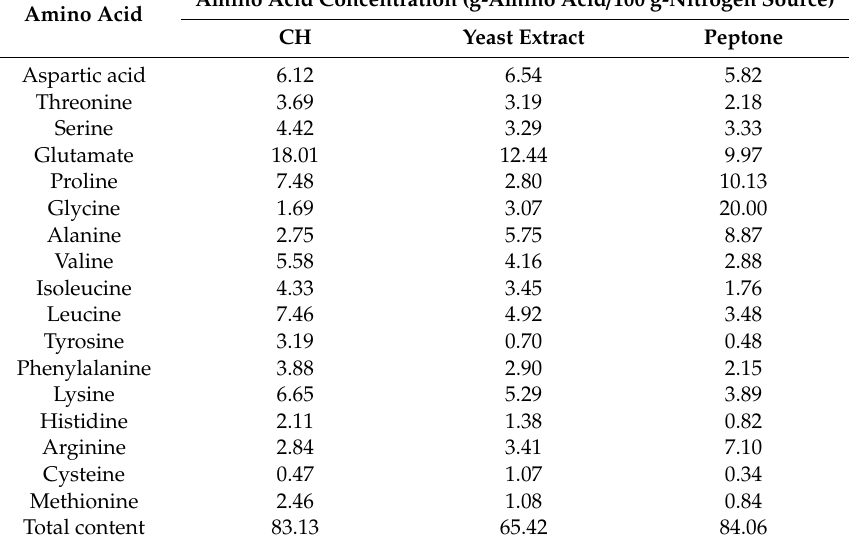
Table 2. Amino acid composition in nitrogen